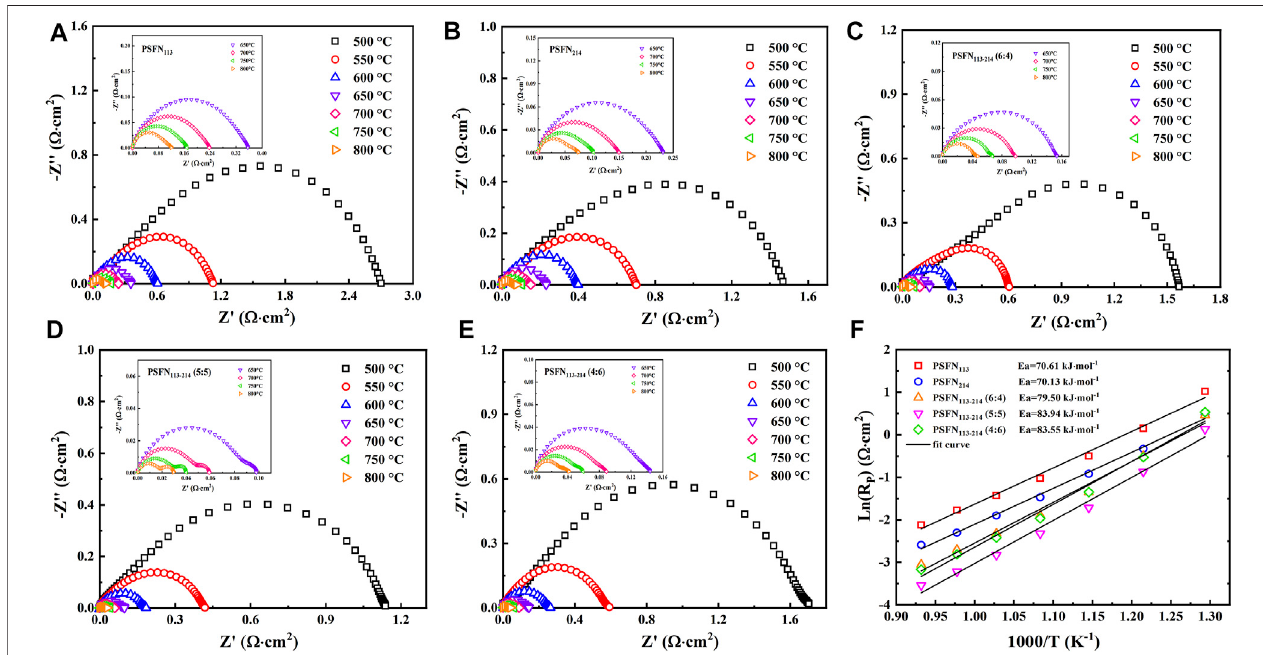
FIGURE 6 | Electrochemical impedance spectrum of a symmetrical cell: (A) PSFN 113 , (B) PSFN 214 , (C) PSFN 113-214 (6:4), (D) PSFN 113-214 (5:5), (E) PSFN 113-214 (4:6), and (F) polarization resistance varies Arrhenius curve of temperature change.